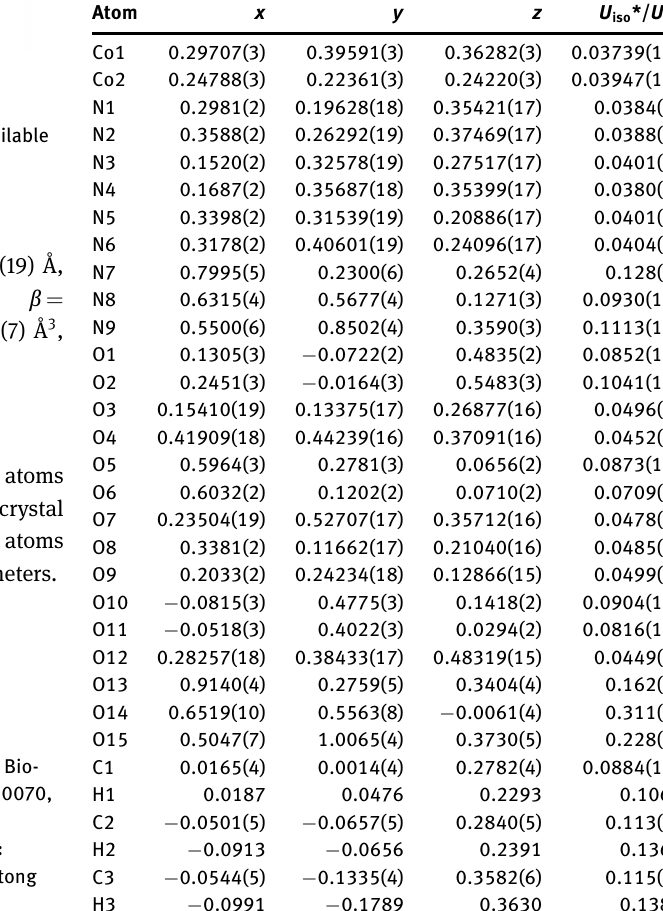
Table 2: Fractional atomic coordinates and isotropic or equivalent isotropic displacement parameters (Å 2